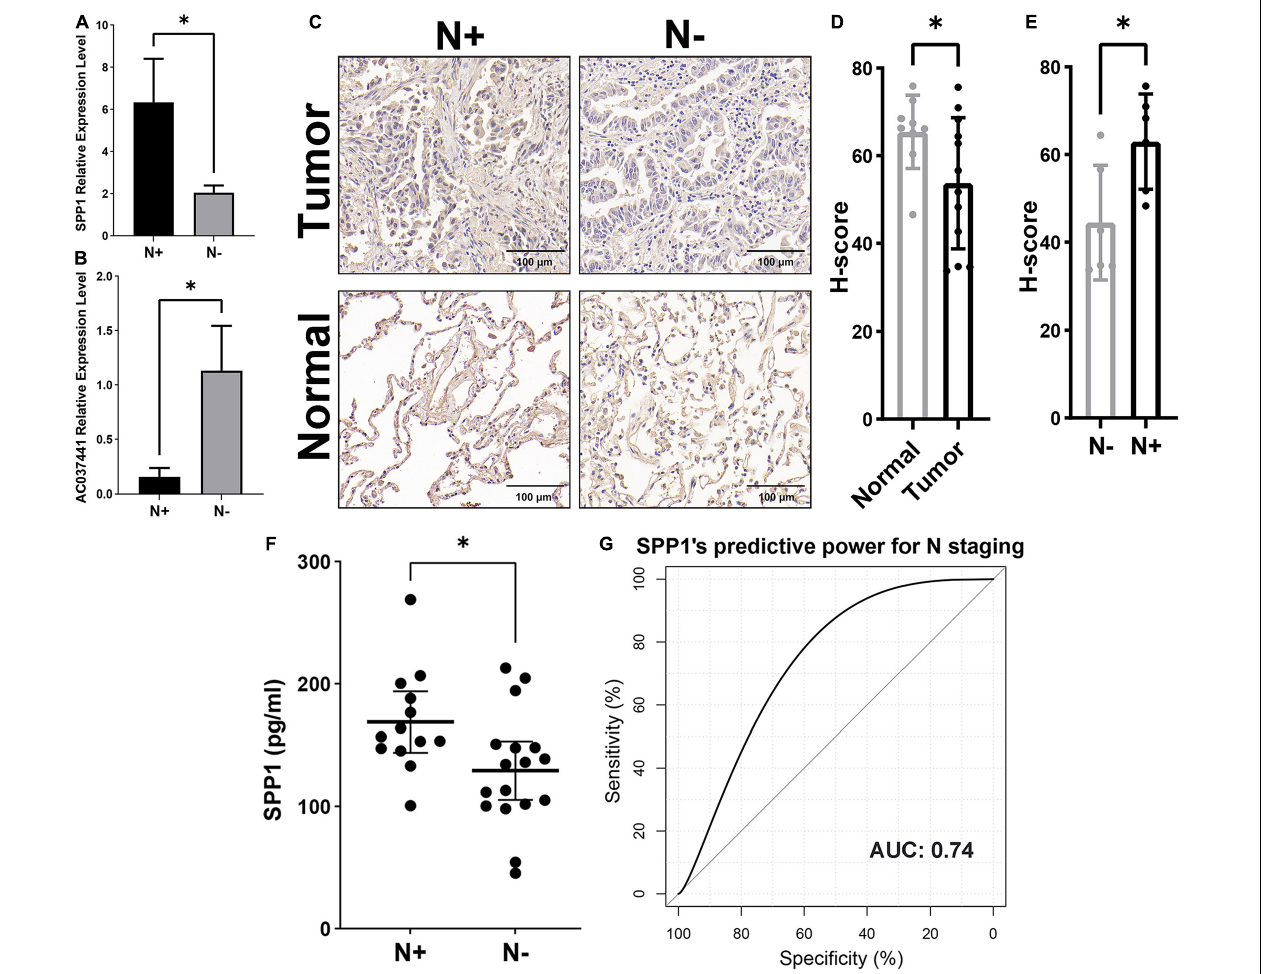
FIGURE 8 | Validation of SPP1 as a potential biomarker for early lymph node metastasis by quantitative reverse transcriptase-polymerase chain reaction (qRT-PCR), immunohistochemical (IHC), and enzyme-linked immunosorbent assay (ELISA) assays. The expression levels of SPP1 (A) and lncRNA (AC037441) (B) in tumor samples were compared by qRT-PCR in the lymph node metastasis group versus the non-metastatic group. (C) The representative IHC figures of SPP1 in Stage-T1 LUAD patients with and without lymph node metastasis. (D) The H-scores of SPP1 in tumor tissues ( n = 12) were lower than that of adjacent normal tissues ( n = 9). (E) The tumor sample scores distinction of SPP1 in the lymph node metastatic versus non-metastatic groups. (F) Comparison of the SPP1 concentration in the plasma of Stage-T1 LUAD patients between patients with lymph node metastasis and those without metastasis. (G) The receiver operating curve (ROC) and area under the curve (AUC) were used to evaluate the predictive efficiency of plasma SPP1 concentrations for early lymph node metastasis. * p <